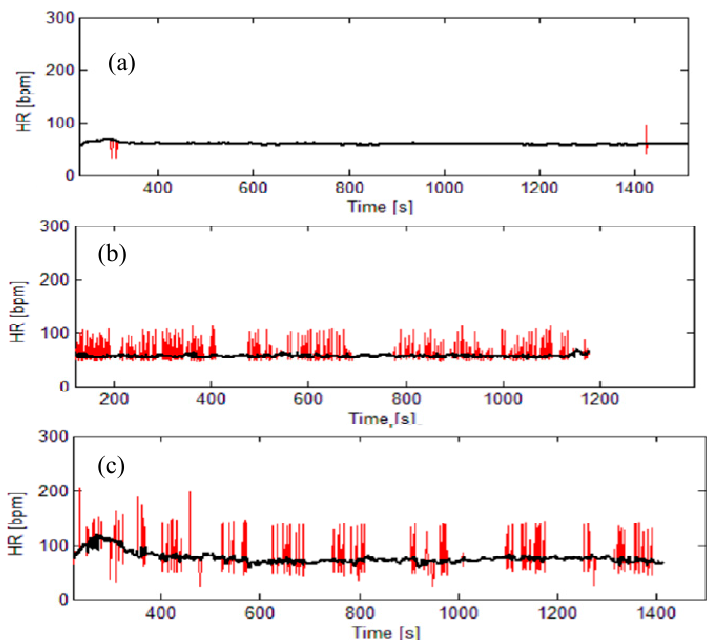
Figure 2. Typical heart rate (HR) signals: red lines-raw signals with artifacts, black lines—corrected signals. ( a ) almost ideal signal; ( b ) signal with artifacts; ( c ) signal with ectopic beats (and artifacts). The signals ( b ) and ( c ) cannot be used for further processing.